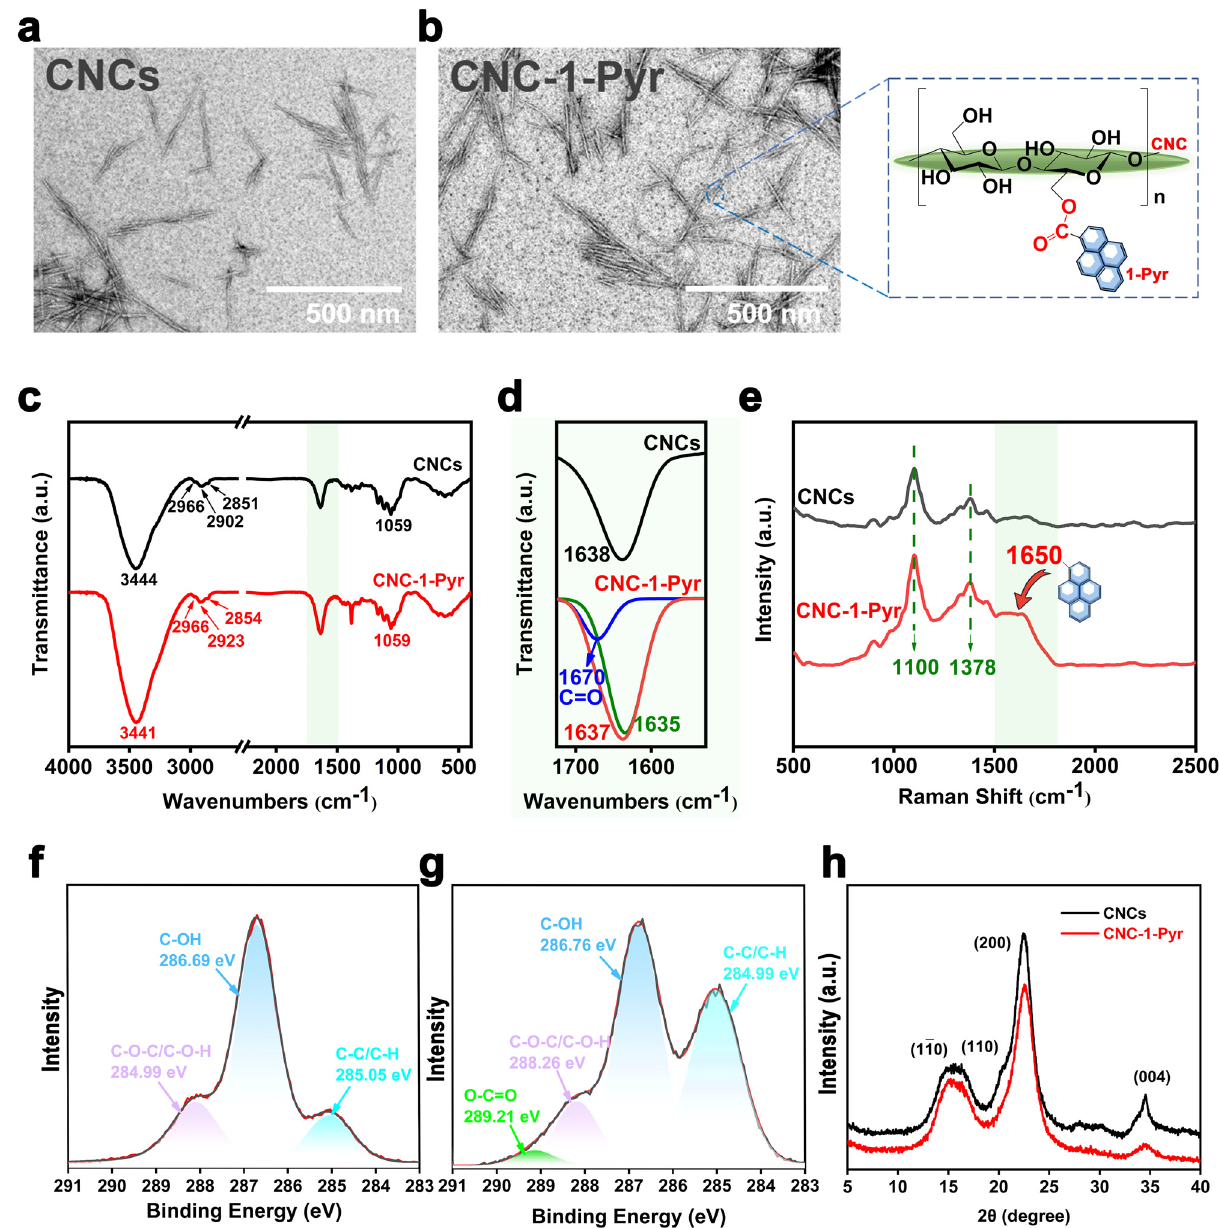
Figure 1: Structural characterizations of pyrene - modi fi ed CNCs: ( a and b ) TEM images of CNCs and CNC - 1 - Pyr, ( c ) FT - IR spectra of CNCs and CNC - 1 - Pyr, ( d ) enlarged absorption peaks in a range of 1,530 – 1,730 cm − 1 as marked in ( c ) , ( e ) Raman spectra of CNCs and CNC - 1 - Pyr ( f and g ) high - resolution XPS of C 1s in ( f ) CNCs, ( g ) CNC - 1 - Pyr, and ( h ) XRD of CNCs and CNC - 1 -